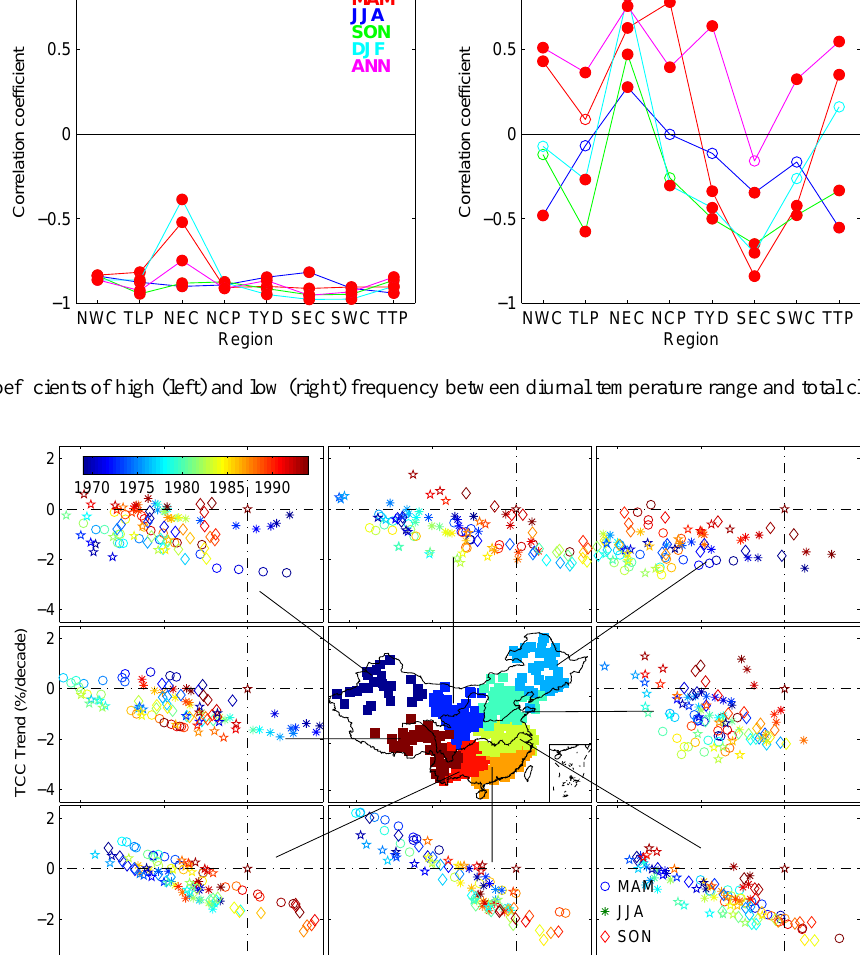
(Sanchez-Lorenzo and Wild, 2012; Wang et al., 2012), to study co-variation of SSD and DTR. The advantage of